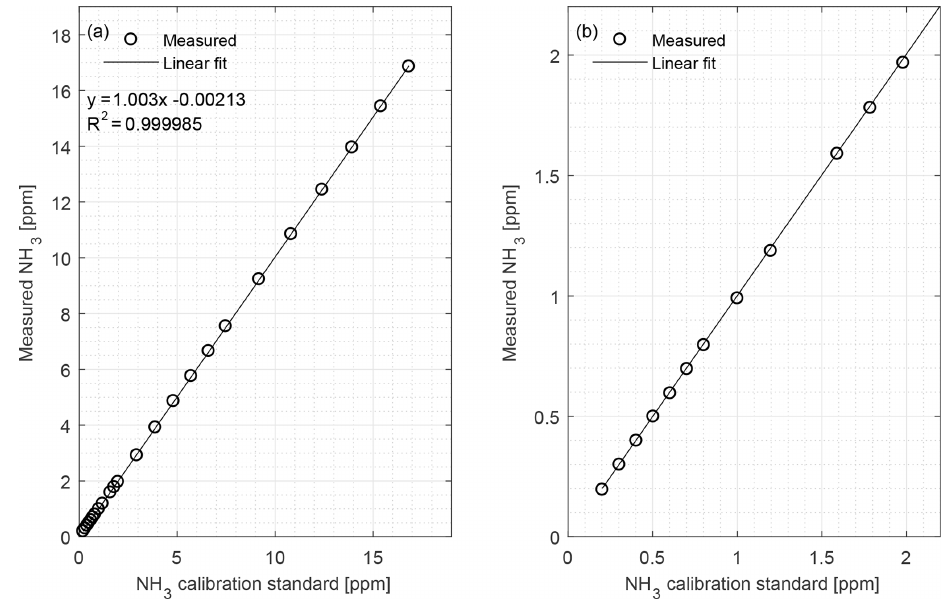
Figure 2. (a) Calibration curve of the CRDS from 0.20 to 16.8ppm NH 3 conducted under laboratory conditions; (b) calibration curve limited to 0 to 2ppm. Symbols represent measured values, error bars the standard deviation and the line is the fitted regression